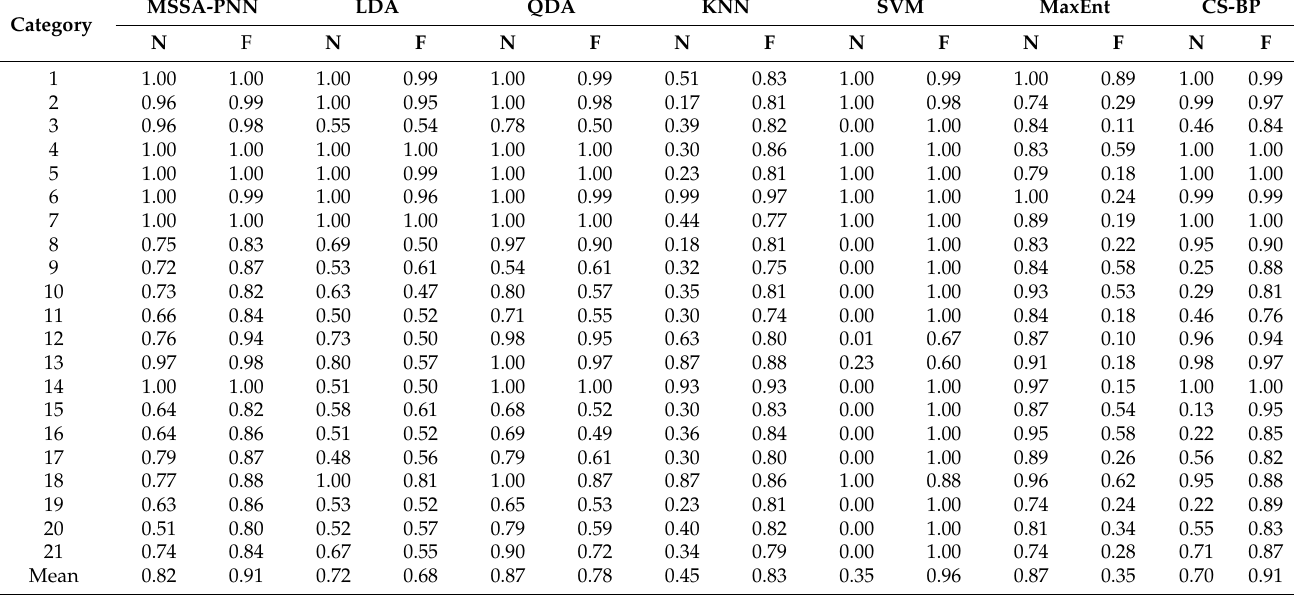
Table 8. Predicted diagnostic rates of normal states and fault state corresponding to each fault class for different classifiers (N represents normal states, F corresponds to fault